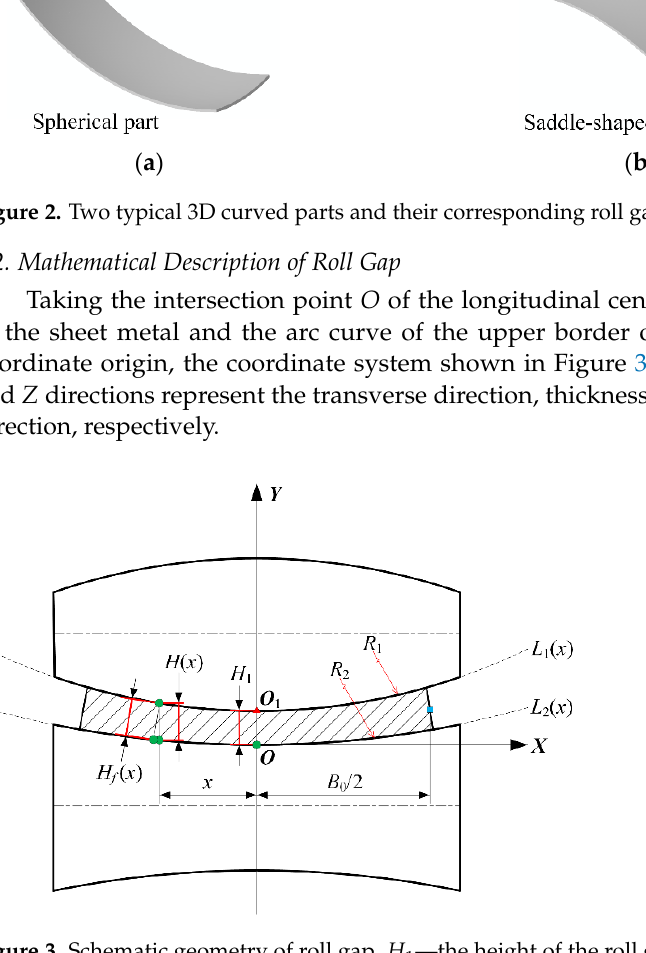
Figure 3. Schematic geometry of roll gap. H 1 —the height of the roll gap at the center of the roll gap; H ( x )—the vertical height of the roll gap when the X coordinate value is x ; H f ( x )—the height of the roll gap in the normal direction when the X coordinate value is x ; x —X axis coordinate value; O —Origin of coordinate system; O 1 —The intersection of the Y axis and the lower border arc of the convex roller; R 1 —generatrix radius of the convex roller; R 2 —generatrix radius of the concave roller; B 0 —initial width of sheet metal; L 1 ( x )—lower border function of the convex roller; L 2 ( x )—upper border function of the convex roller.